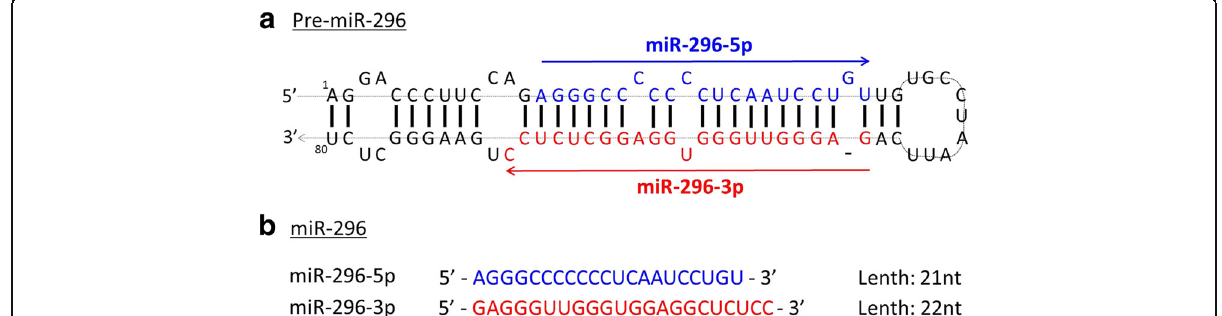
Fig. 1 The structure of the 80 nt pre-miR-296 (pre-miR-296) precursor and mature miR-296. a Homo sapiens stem-loop structure of pre-miR-296. Two different mature miRNAs are produced from this precursor: miR-296-5p (sequence in blue) and miR-296-3p (sequence in red). The orientations (5 ′ to 3 ′ ) are indicated by the direction of the arrows. b Mature sequence of hsa-miR296-5p and